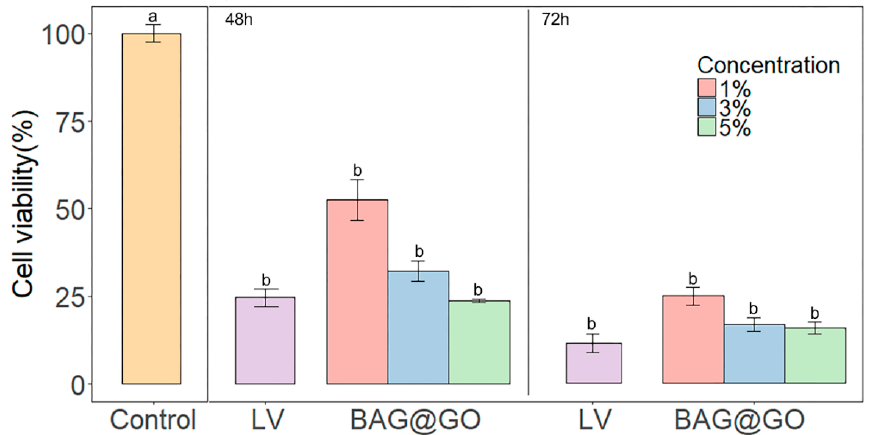
Figure 5. Cell viability test by HGF cytotoxicity on cured LV and BAG@GO-containing orthodontic bonding adhesive. Cell viability test results after 48 and 72 h are shown. The same letter indicates no statistically significant difference between the groups ( p < 0.05) by Duncan’s multiple comparison test. Error bars are shown ± standard deviation.